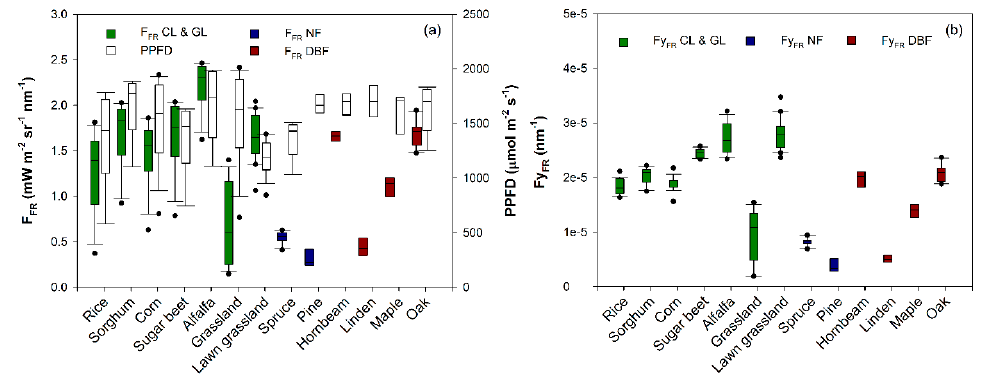
Figure 1. ( a ) Plot of the median, 10th, 25th, 75th and 90th percentiles as vertical boxes of the F; and ( b ) apparent fluorescence yield in the O 2 -A band for different species. Full bars refer to F and Fy estimation, while empty bars refer to the incident photosynthetic photon flux density (PPFD) expressed in µmol·m − 2 ·s − 1 . The statistics refer to 20 samples for each species. CL: cropland, GL: grassland, NF: Needleleaf Forest, DBF: Deciduous Broadleaf Forest. Sun-induced chlorophyll fluorescence at the O 2 -B band (F R ) was measured on a reduced number of land cover classes, mainly broadleaf and needleleaf forest species. F R and Fy R values are shown in Figure 2: maximum F R values at maximum canopy development ranged from 0.1 mW·m − 2 ·sr − 1 ·nm − 1 for pine trees to 0.8 mW·m − 2 ·sr − 1 ·nm − 1 for broadleaf trees and grasslands with a maximum incident PPFD between 1800 and 1900 µmol·m − 2 ·s − 1 (Figure 2a). Lawn grassland and hornbeam showed the maximum Fy R among the investigated species (Figure 2b).